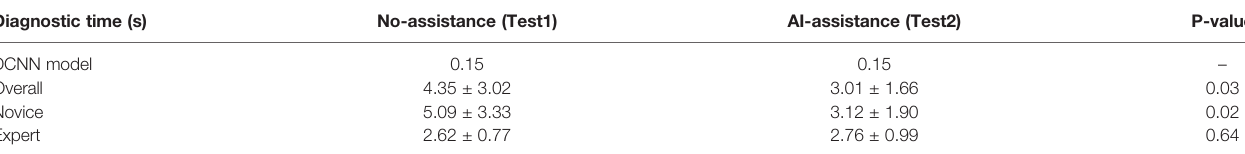
TABLE 3 | Diagnostic time of Endoscopists with or without the Assistance of AI.